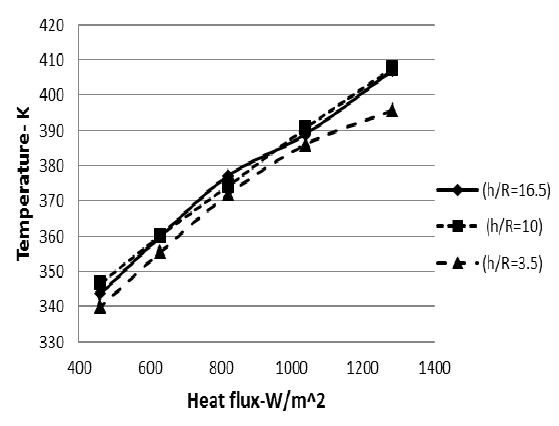
Figure 12. Local Nu with different depth/radius ratios at 35 V (628.051 W/m 2 ).